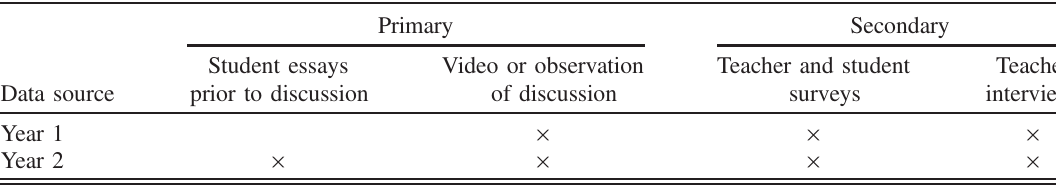
TABLE I. Primary and secondary sources of data for this